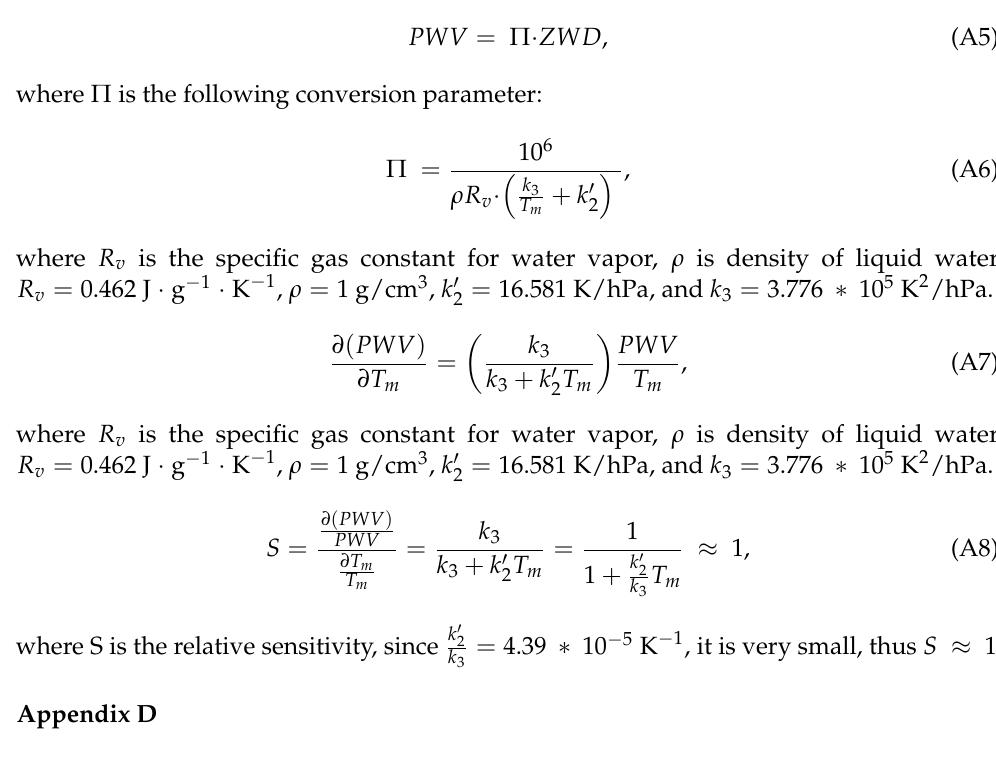
Figure A1. Tm derived from four reanalysis and radiosonde data under different heights (ground height of the station, 925, 850, 700, 600, 500, 400, and 300 hPa) and the tropopause.